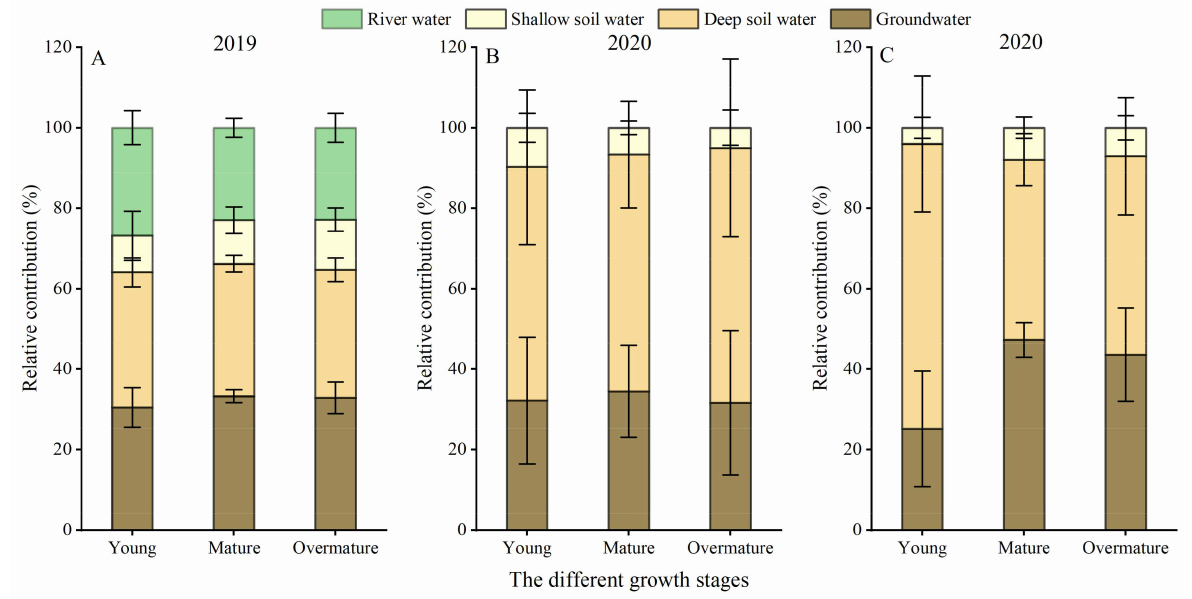
Figure 4. Variation in the percentage contribution of potential water sources for P. euphratica ( A , B ) and T. chinensis ( C ) at different growth stages in 2019 and